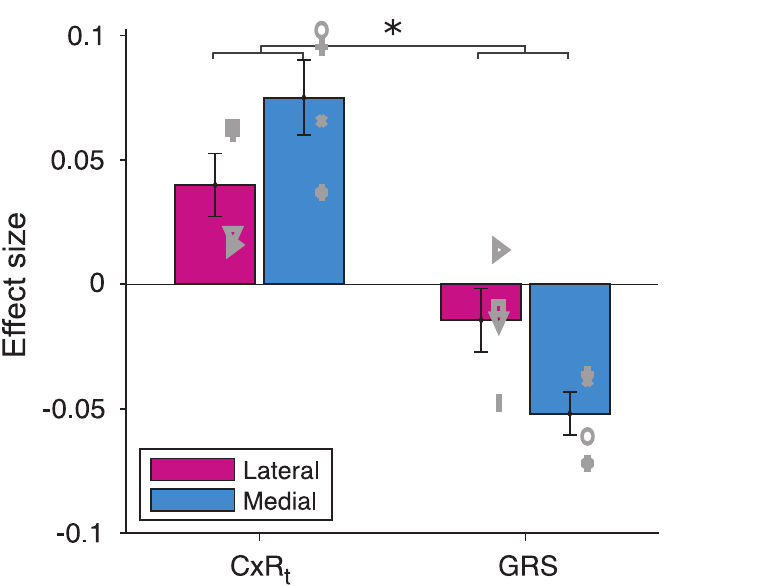
Fig 4. Lateral frontal lobe lesions impair both local and global reward learning. Compared to Medial patients (blue), lesions to the lateral frontal lobe (pink) in adult humans reduced both local and global reward learning. This was apparent by a simultaneous reduction of the CxR t effect sizes and a less negative GRS effect ( � p < 0.05; symbols indicate individual patients). Data for this figure are available in S1 Data (Figure 4 tab).